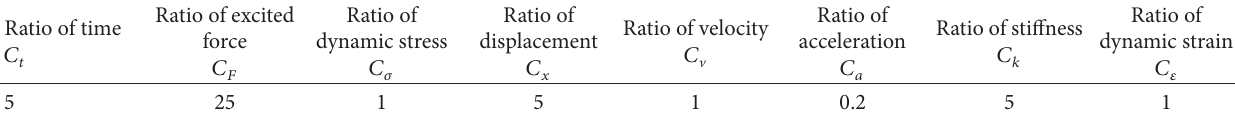
Table 3: The similar relations of the operating condition parameters of large vibrating